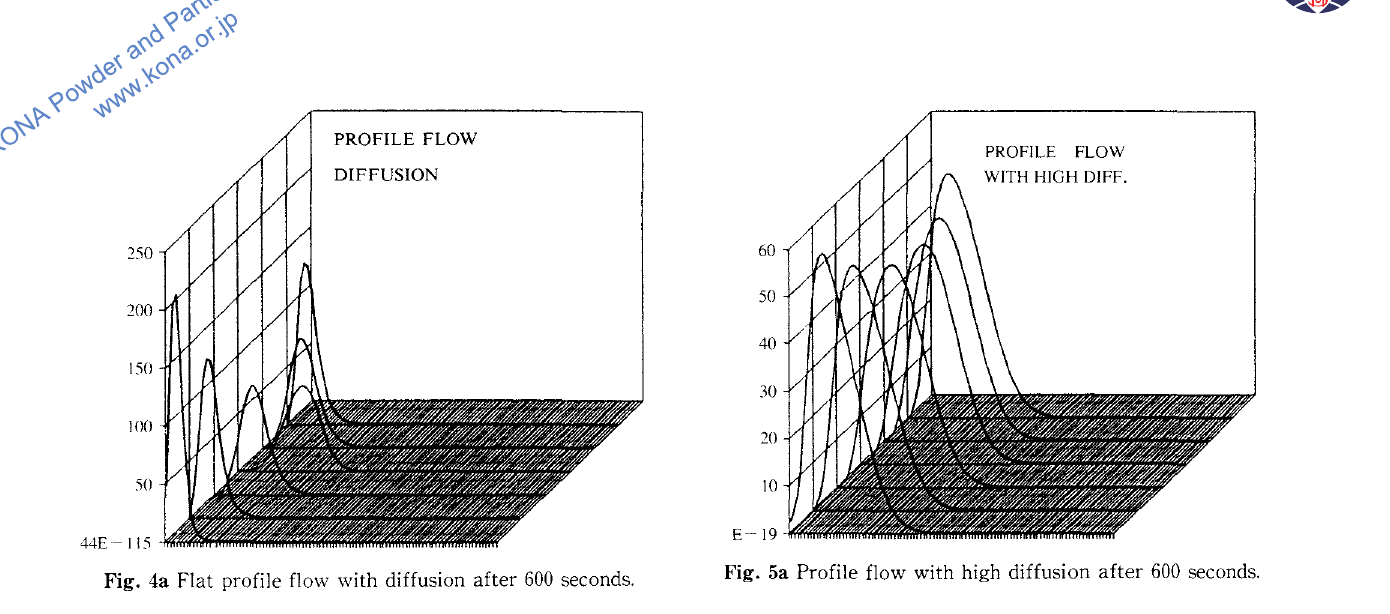
Fig. 4a Flat profile flow with diffusion after 600 seconds.